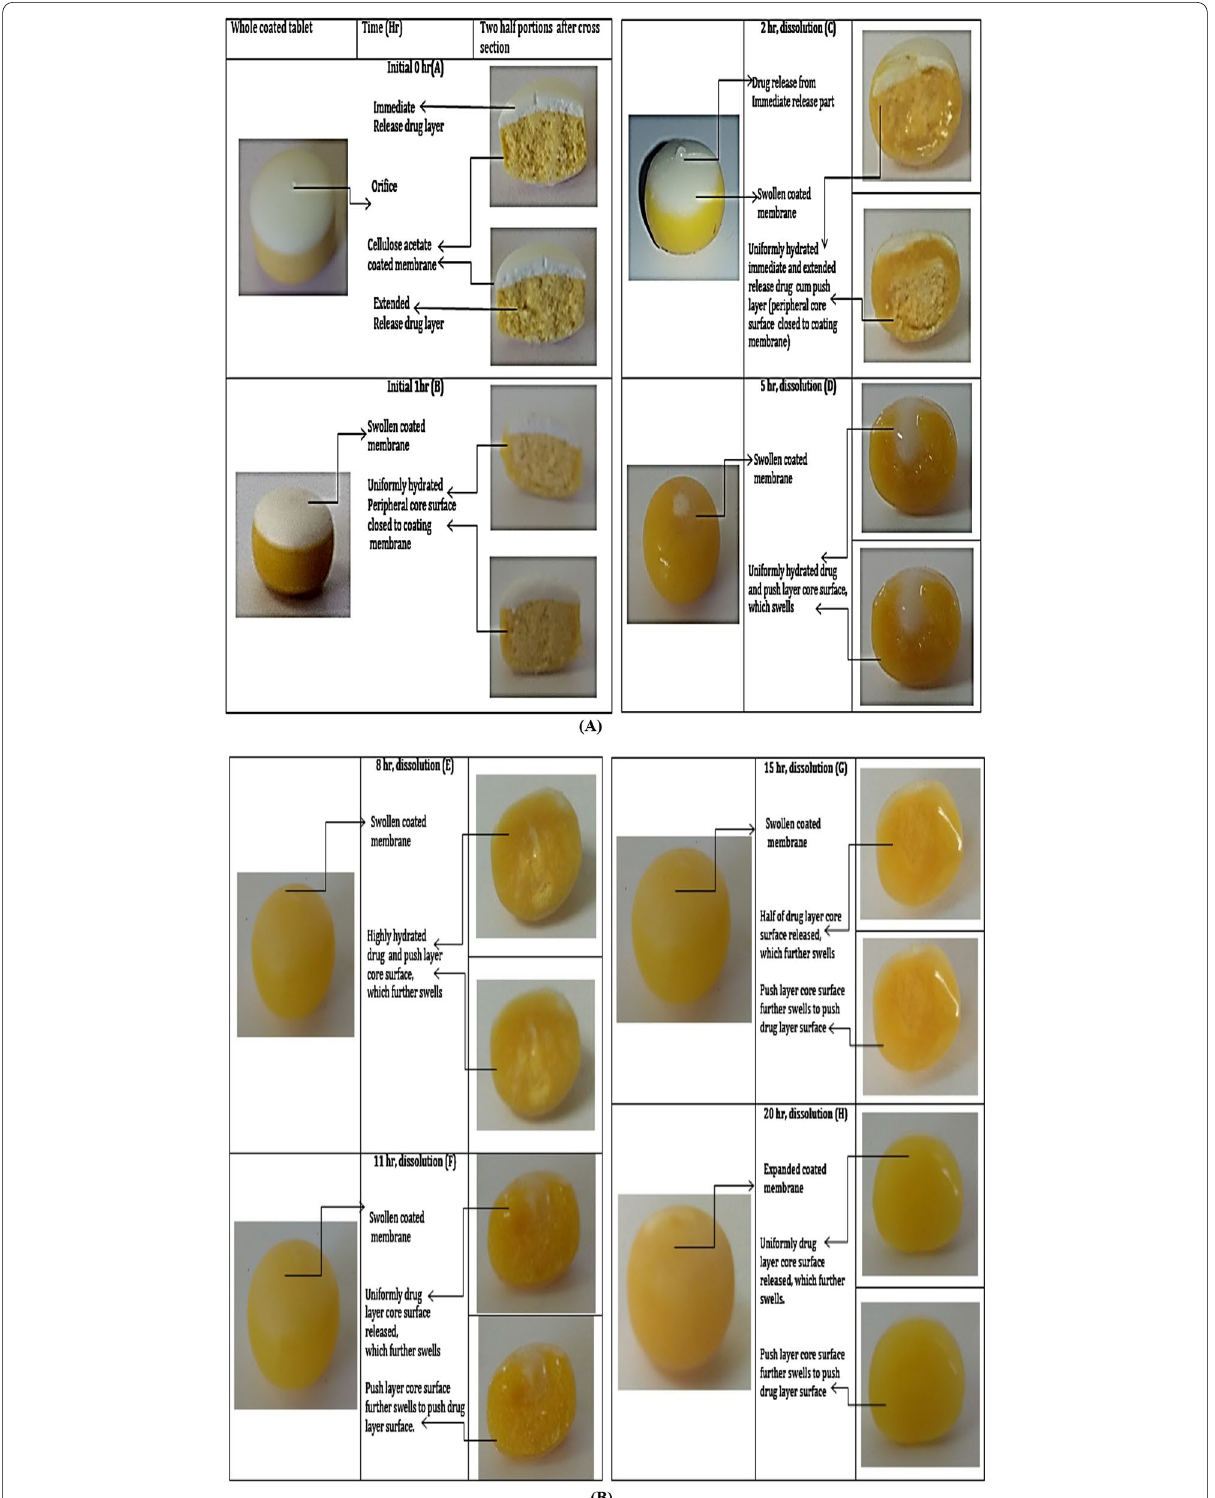
Fig. 5 TSP-18 coated tablets after exposure to the dissolution buffer (hydration study) at 0–20